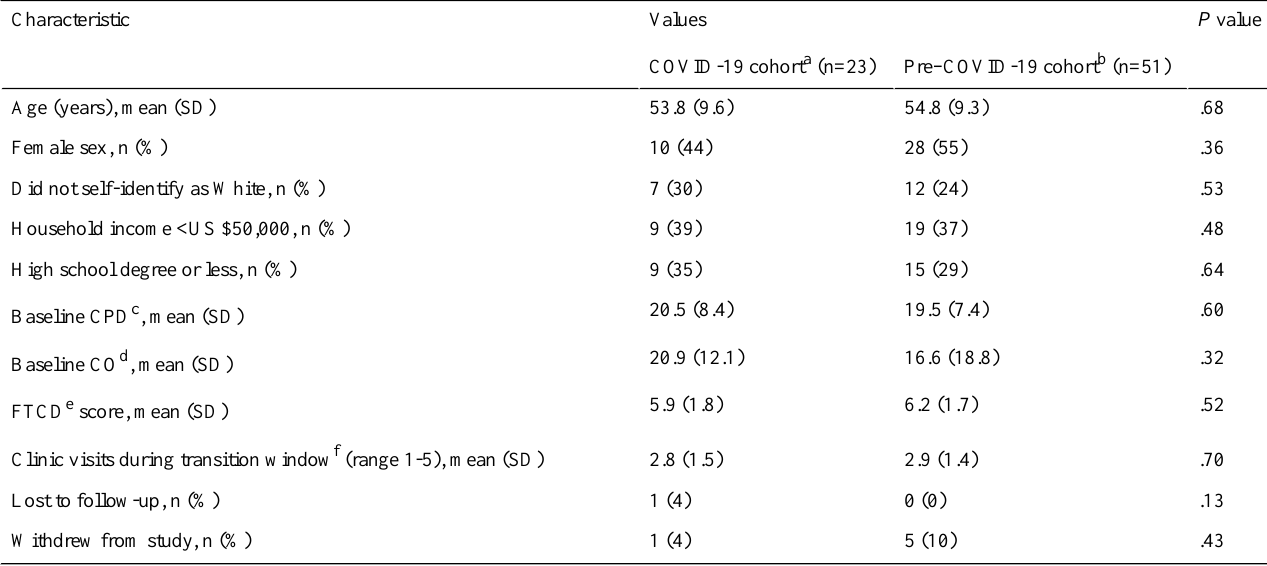
Table 1. Selected demographic, smoking, and visit attendance characteristics among smoking cessation clinical trial participants by study cohort.